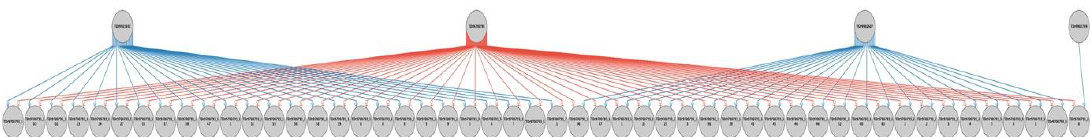
Figure 2. Pedigree reconstruction of polycross family TDr1685 based on Helium pedigree visualization. TDr9501932, TDr9902789 and TDr9902607 = male parents (blue); TDr9700793 = female parent (red). The pedigree recovery of families TDr1686, TDr1687, TDr1688, TDr1689, TDr1690 and TDr1691